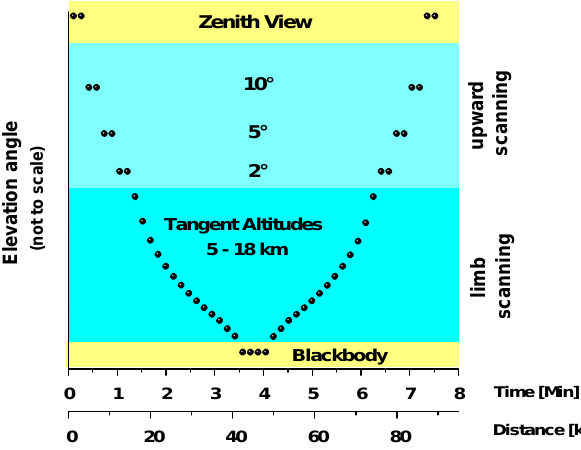
Fig. 2. Typical NESR of a single channel 1 spectrum under flight conditions (grey curve) and moving average (black curve).